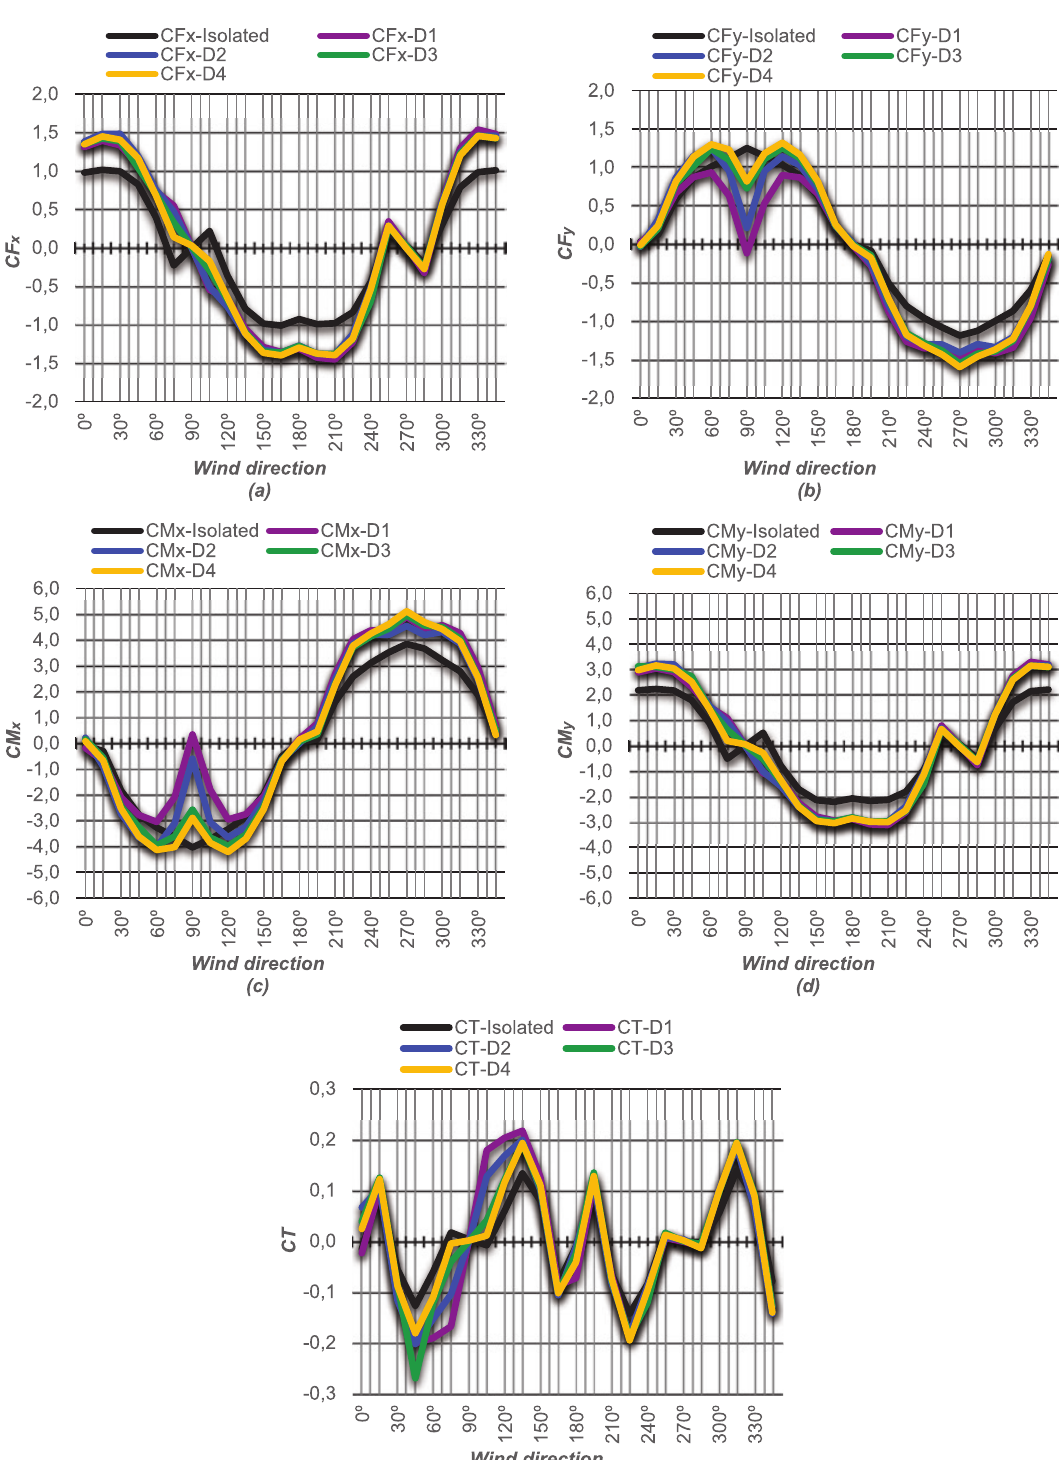
Figure 8 Load coefficients for the vicinity V1: (a) Resultant force in the direction of the X axis; (b) Resultant force in the direction of the Y axis; (c) Base momenta round axis X; (d) Base moment around axis Y; (e) Torsion around building